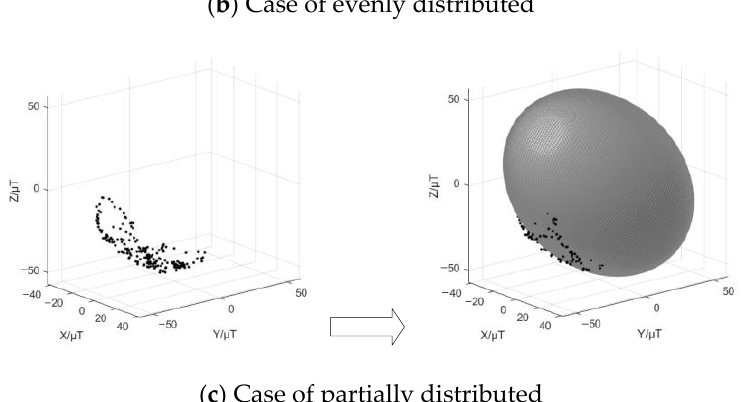
Figure 6. The orthogonal tri-axis magnetic field distribution and the fitted ellipsoid.